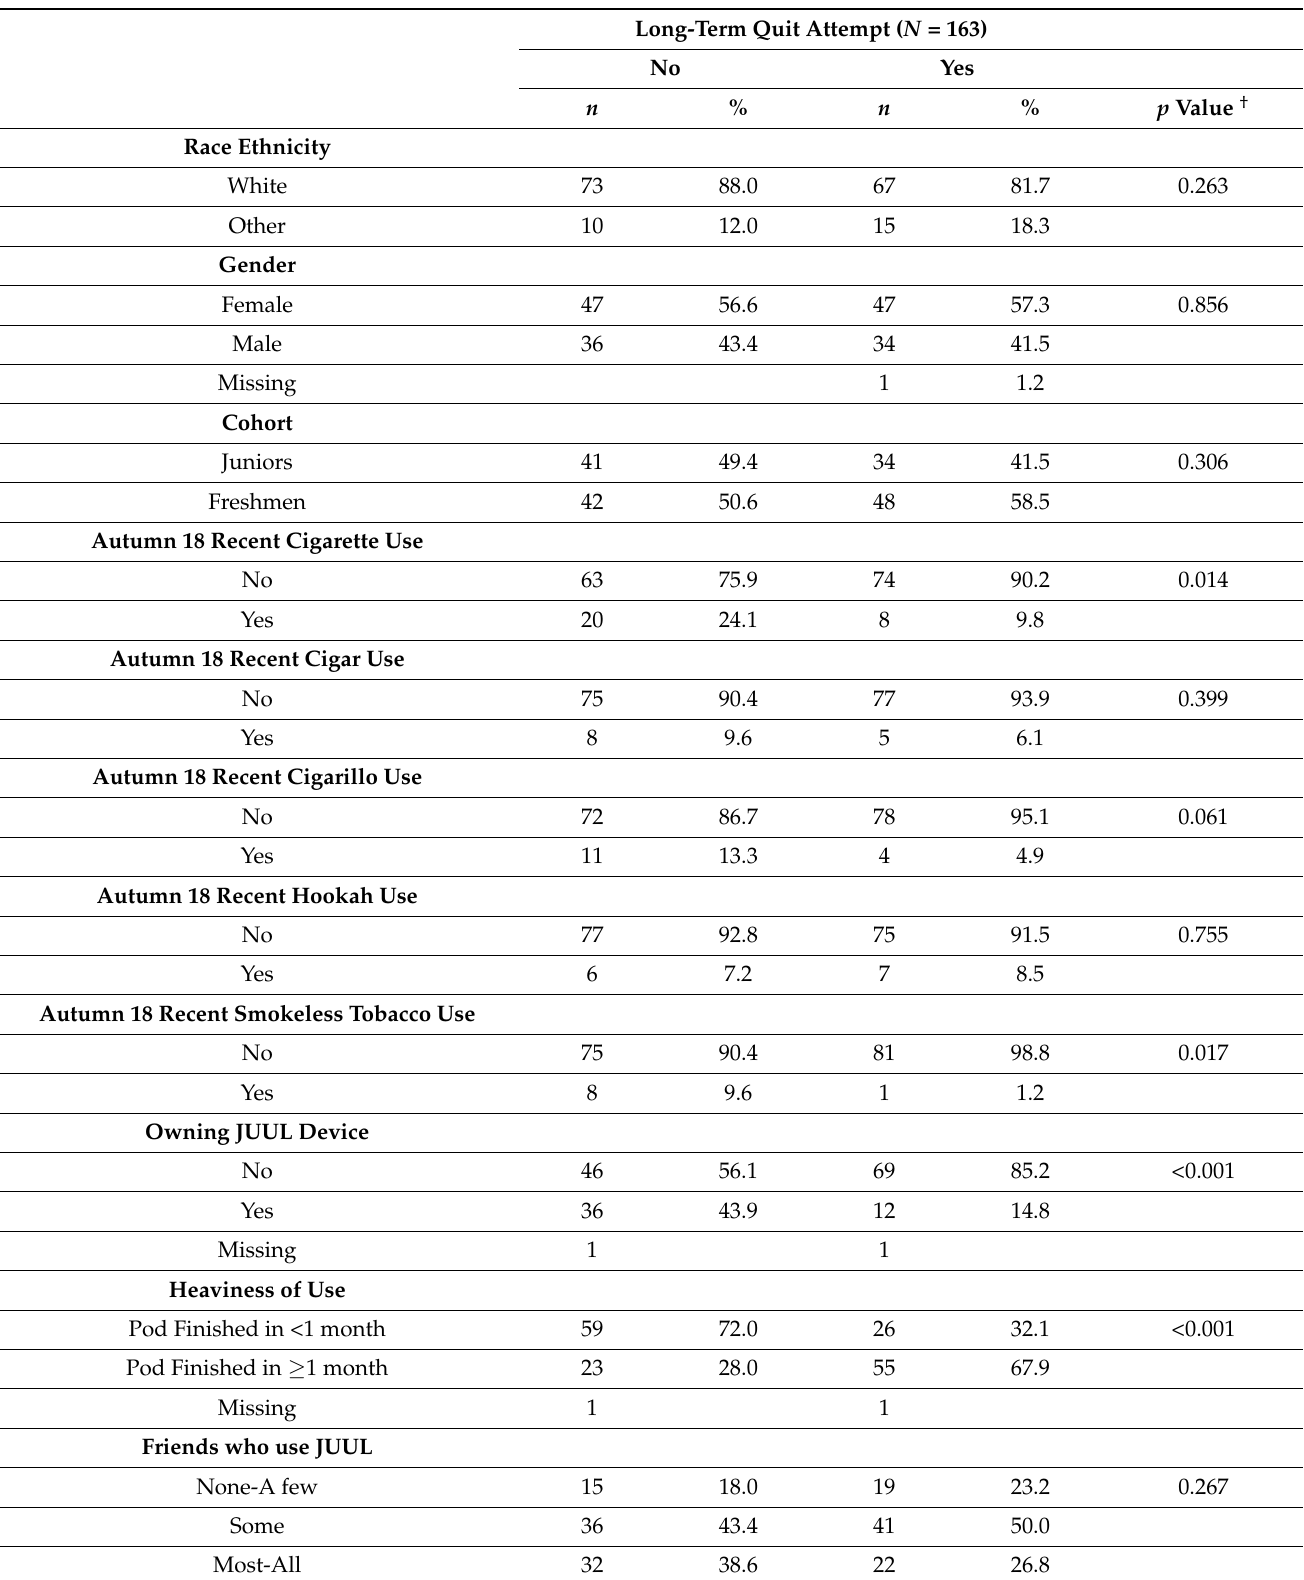
Table 2. Descriptive Characteristics of Current JUUL users by Long-Term Quit